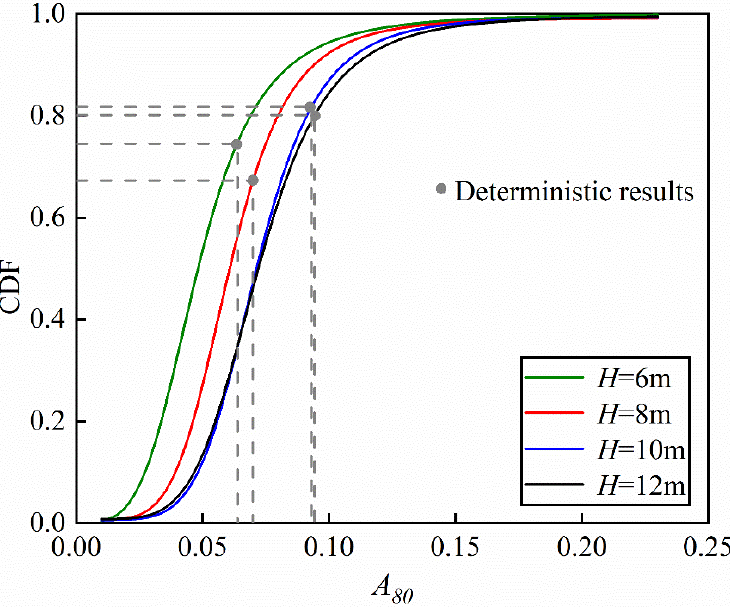
Figure 10. Cumulative distribution function (CDF) of A 80 under different embedment depths of tun- nel.